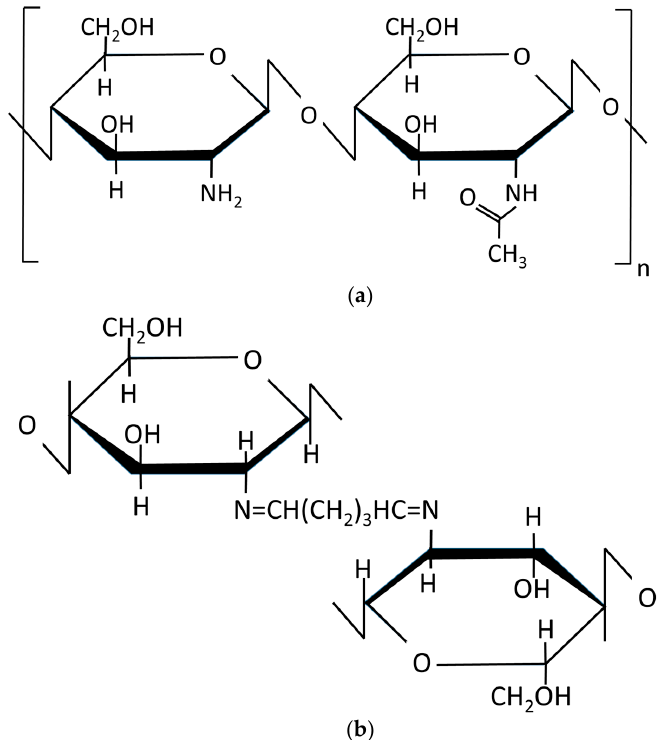
Figure 1. Structure of ( a ) chitosan and ( b ) glutaraldehyde (GLA)-crosslinked chitosan [17].